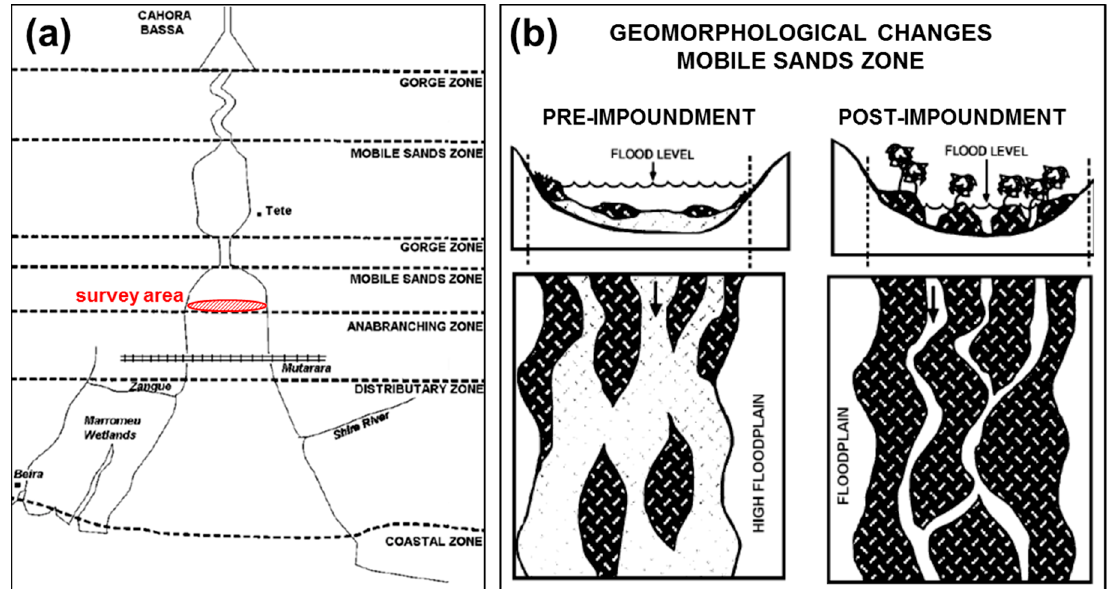
Figure 10. ( a ) Morphological zonation of the lower Zambezi valley. ( b ) Geomorphological changes due to Cahora Bassa dam. Adapted from Davies et al. [9] with permission from Prof. Richard Beilfuss and Schweizerbart Science Publishers [41].